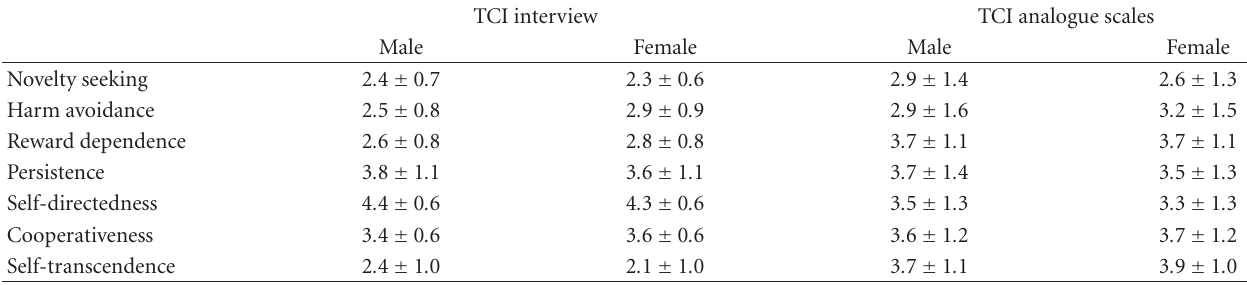
Table 3: Mean scores of both personality measures.